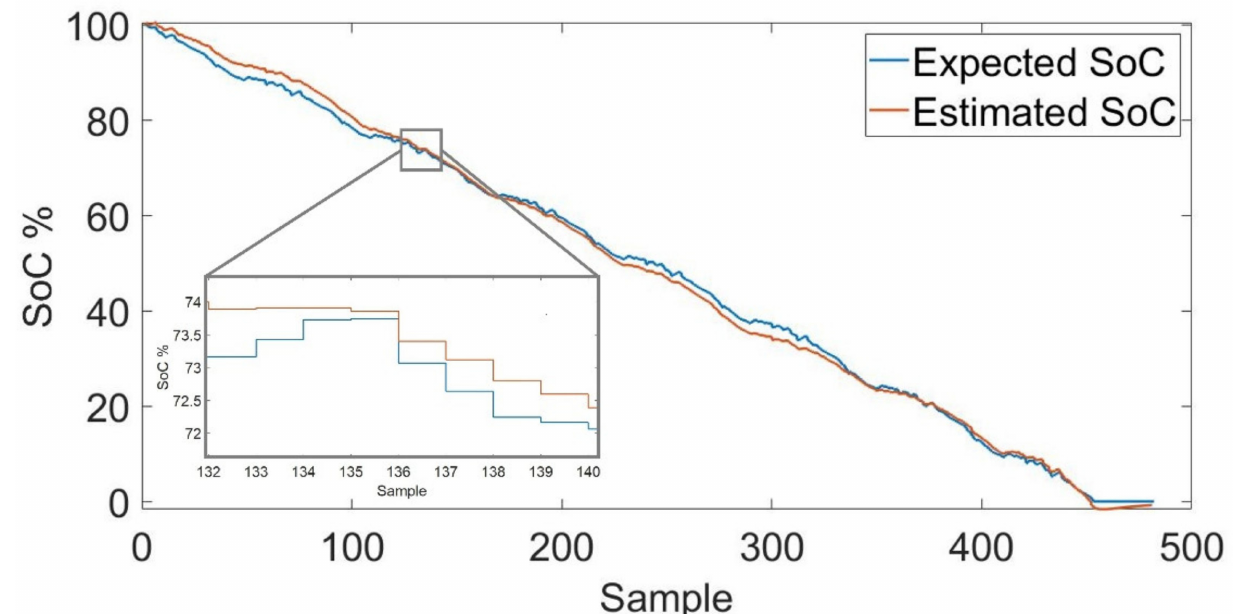
Figure 3. Comparison of expected SoC with SoC processed data on the FPGA board.